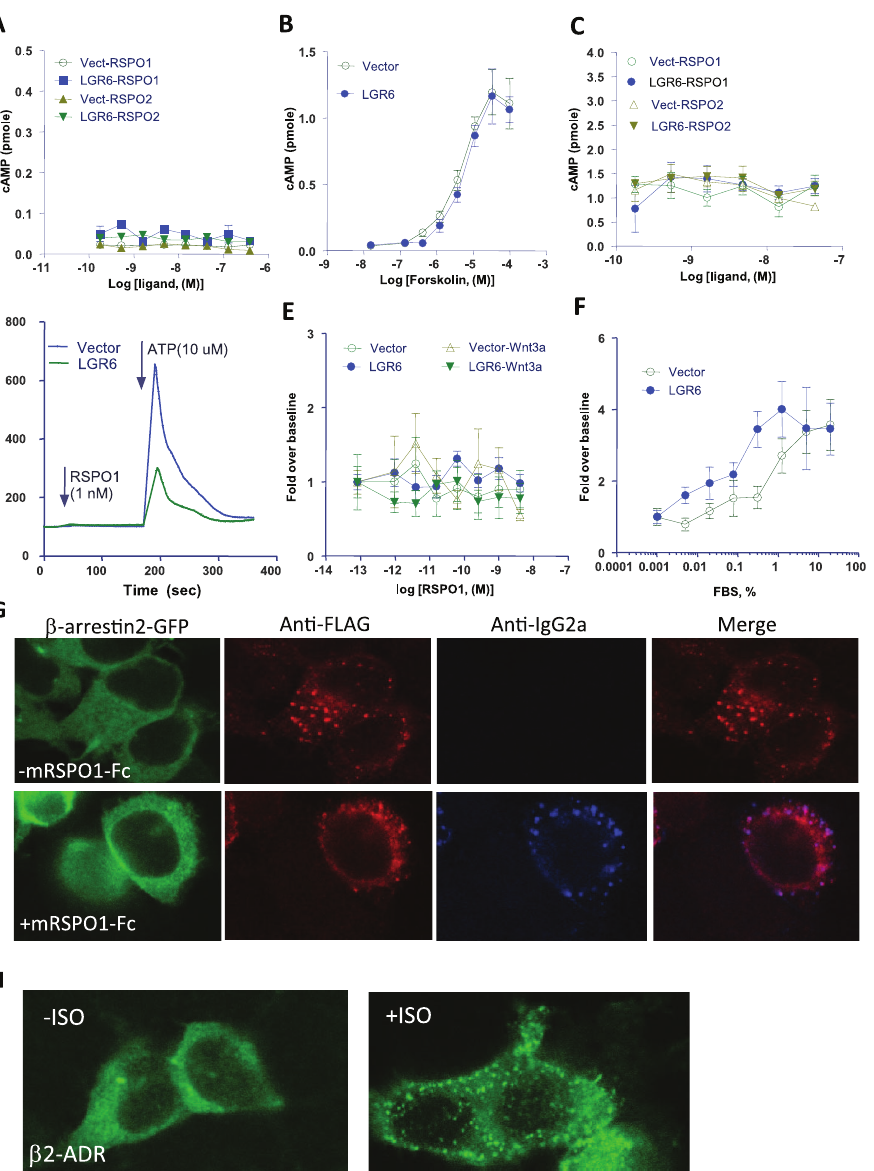
Figure 3. LGR6 is not coupled to heterotrimeric G proteins or to b -arrestin following R-spondin stimulation. A, No cAMP response was detected in vector and LGR6 cells treated with RSPO1–2. B, Forksolin showed a strong stimulation of cAMP production in both cells. C, RSPO1–2 treatments had no effect on forskolin-stimulated cAMP production in vector and LGR6 cells. D, No Ca 2 + mobilization was induced in vector and LGR6 cells in response to RSPO1, whereas ATP gave a robust response in both cells. E, Stimulation of LGR6 and vector cells by RSPO1 had no effect in the G a (12/13) pathway using the serum response factor reporter enzyme assay. F, FBS gave a dose-dependent response in the serum response factor reporter enzyme assay. G, No translocation of b -arrestin was observed in LGR6 cells treated with mRSPO1-Fc, whereas colocalization of mRSPO1-Fc with LGR6 was confirmed. H, Robust translocation of b -arrestin was observed in HEK293 cells transfected with b 2-adrenergic receptors and stimulated with its agonist isoproterenol. doi:10.1371/journal.pone.0037137.g003 FLAG-tagged LGR6 WT or insGRS after sorting with anti-Flag colon cancer cell lines expressed significant levels of RSPOs while antibody (Fig. 5 D–E). No difference among the three cell lines previous published results showed HeLa cells express high levels of expressing vector, LGR6-WT or LGR6-insGRS was observed in RSPO3 [12] (Fig. 5B). To examine the effect of LGR6 on growth growth rate as measured by the xCelligence assay (data not and migration of cancer cells, we attempted to overexpress LGR6 shown). We then compared migration of the three cell lines treated WT and insGRS mutant in SW620 cells which have relative low with vehicle control, RSPO1, Wnt3a, or Wnt3a + RSPO1. No expression of LGR4–6 and are routinely used as a model of colon significant difference in baseline migration was observed among cancer studies. However, repeated efforts failed to establish cell the three cell lines (Fig. 5C). Interestingly, cells expressing LGR6- lines stably expressing WT or mutant LGR6. We then used HeLa WT displayed increased migration when treated with cells as a host cell line and obtained bulk cell lines stably expressing